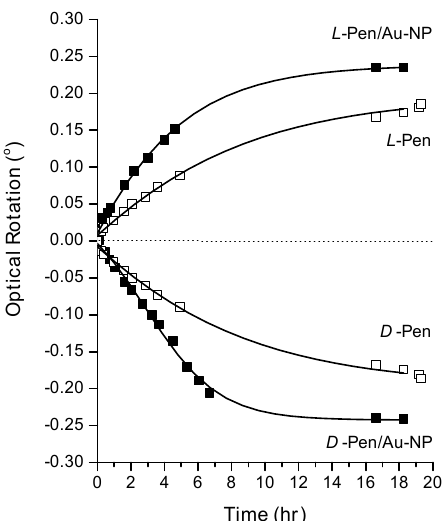
Figure 3. Optical rotation versus time by L- and D-Pen-coated Au-NPs and enantiomerically pure L- and D- Pen after exposure to a solution of 0.023 M RS-PO. The curves for D- and L-Pen are fits of a first-order exponential growth curve. The concentration of Au was 0.24 M and the concentration of Pen was 0.025